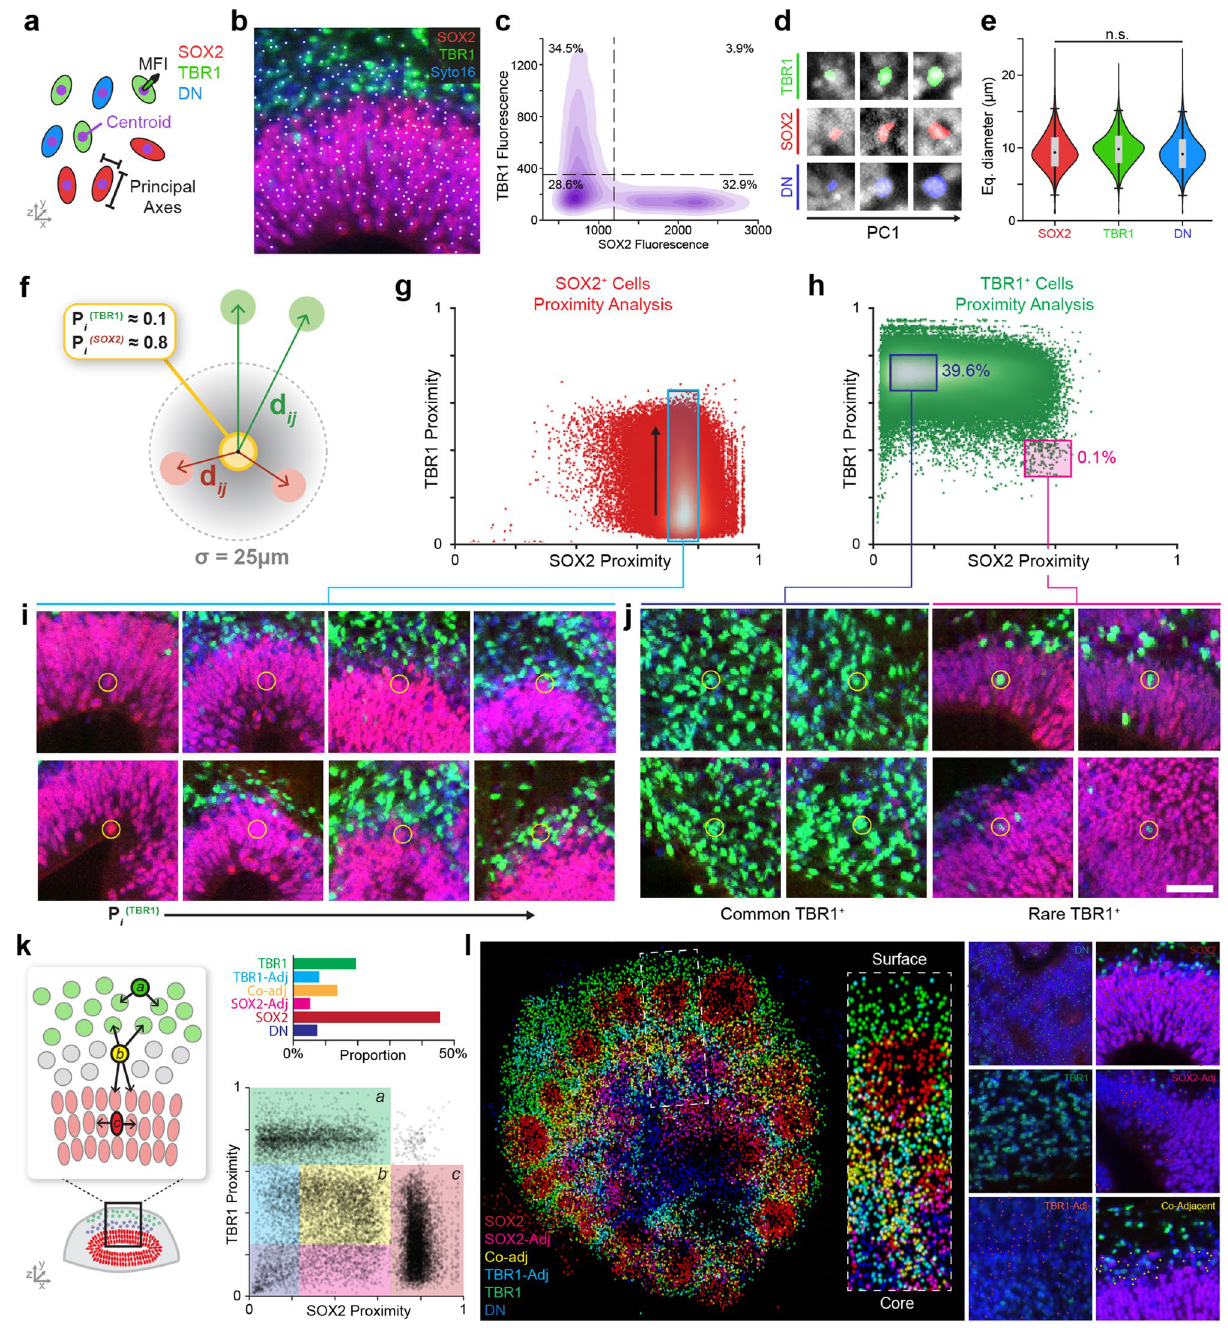
Figure 2. Single-cell detection and analysis. ( a ) Scheme of single-cell morphological characterization. ( b ) Demonstration of automated nuclei detection in 3D datasets. Syto16 in blue, SOX2 in red, TBR1 in green. Scale bar, 100 µm. ( c ) Expression of TBR1 and SOX2 in individual nuclei. Density plot shows gating parameters and population frequency. ( d ) Representative images of segmented nuclei for each cell type showing a range of morphological features sorted by principal component analysis. ( e ) Morphological analysis of individual nuclei shows a consistent equivalent diameter ~ 10 µm for all cell types. ( f ) Detailed scheme of the proximity analysis, which quantifies the distance of each cell’s nearest SOX2 and TBR1 cells using a 25 µm radius to normalize proximities. The proximity score between 0 (distant) and 1 (adjacent) reflects the cell’s spatial context as a function of progenitors and mature neurons. ( g ) Proximity analysis of SOX2 cells shows high proximity to other SOX2 cells. ( h ) Proximity analysis of TBR1 cells shows a high proximity to other TBR1 cells and a rare population of cells with a high SOX2 proximity. ( i ) Images showing the change in SOX2 cell position within the VZ as they increase their proximity score to TBR1 cells. Low proximity to TBR1 (left) reflects cells lining the ventricle whereas higher proximity shows cells at the edge of the ventricular zone (right). ( j ) Representative replicate images of TBR1 cells found in the major and rare populations of the proximity analysis. Scale bar = 50 µm. ( k ) Scheme of spatial context analysis showing the proximity of single cells to the nearest SOX2 and TBR1 cells. Bar graph shows the results of spatial context analysis shown below with “proximity score gates” to define six distinct populations. Gates captured > 99% of all cells. ( l ) Middle optical section of a day 35 organoid dataset showing detected cells colored according to their spatial context subcategorization. Inset shows zoomed view of dotted rectangle region. Right subpanels show instances of six different subpopulations identified by